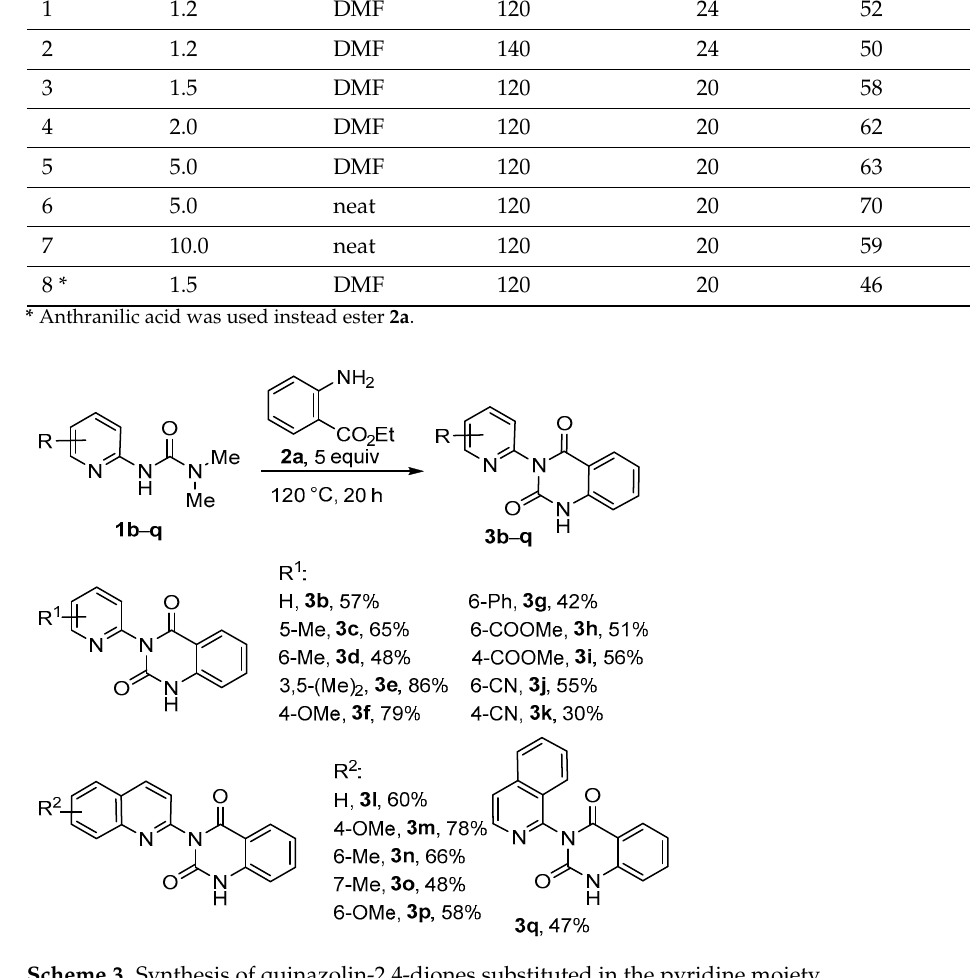
Scheme 3. Synthesis of quinazolin-2,4-diones substituted in the pyridine moiety. The presence of electron-withdrawing groups in the heterocyclic ring also decreased